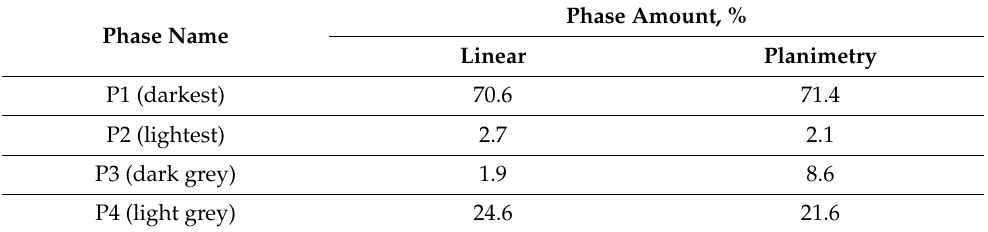
Figure 12. Window of ImageJ during binarization (by manual thresholding) and planimetry analysis of phases ( a ) P1, ( b ) P2, ( c ) P3, ( d ) P4. Table 3. Results of traditional image analysis corresponding to Figure 2 (linear) and Figure 3 (planimetry).